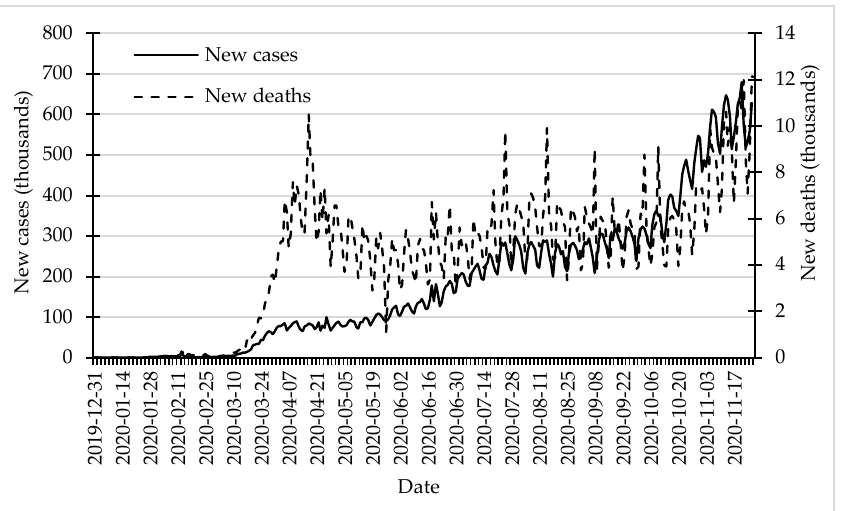
Figure 1. New cases and new deaths of COVID-19 in the period 31 December 2019–26 November 2020. Source: own elaboration on the basis of data from https://ourworldindata.org/coronavirus- source-data (accessed on 15 February 2021).